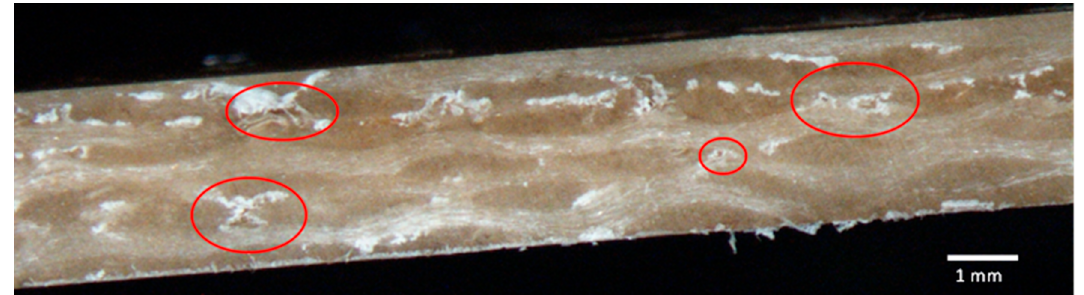
Figure 6. Microscopical picture of the Hemp-EM composite with several voids at the fiber-matrix interface, marked in red.